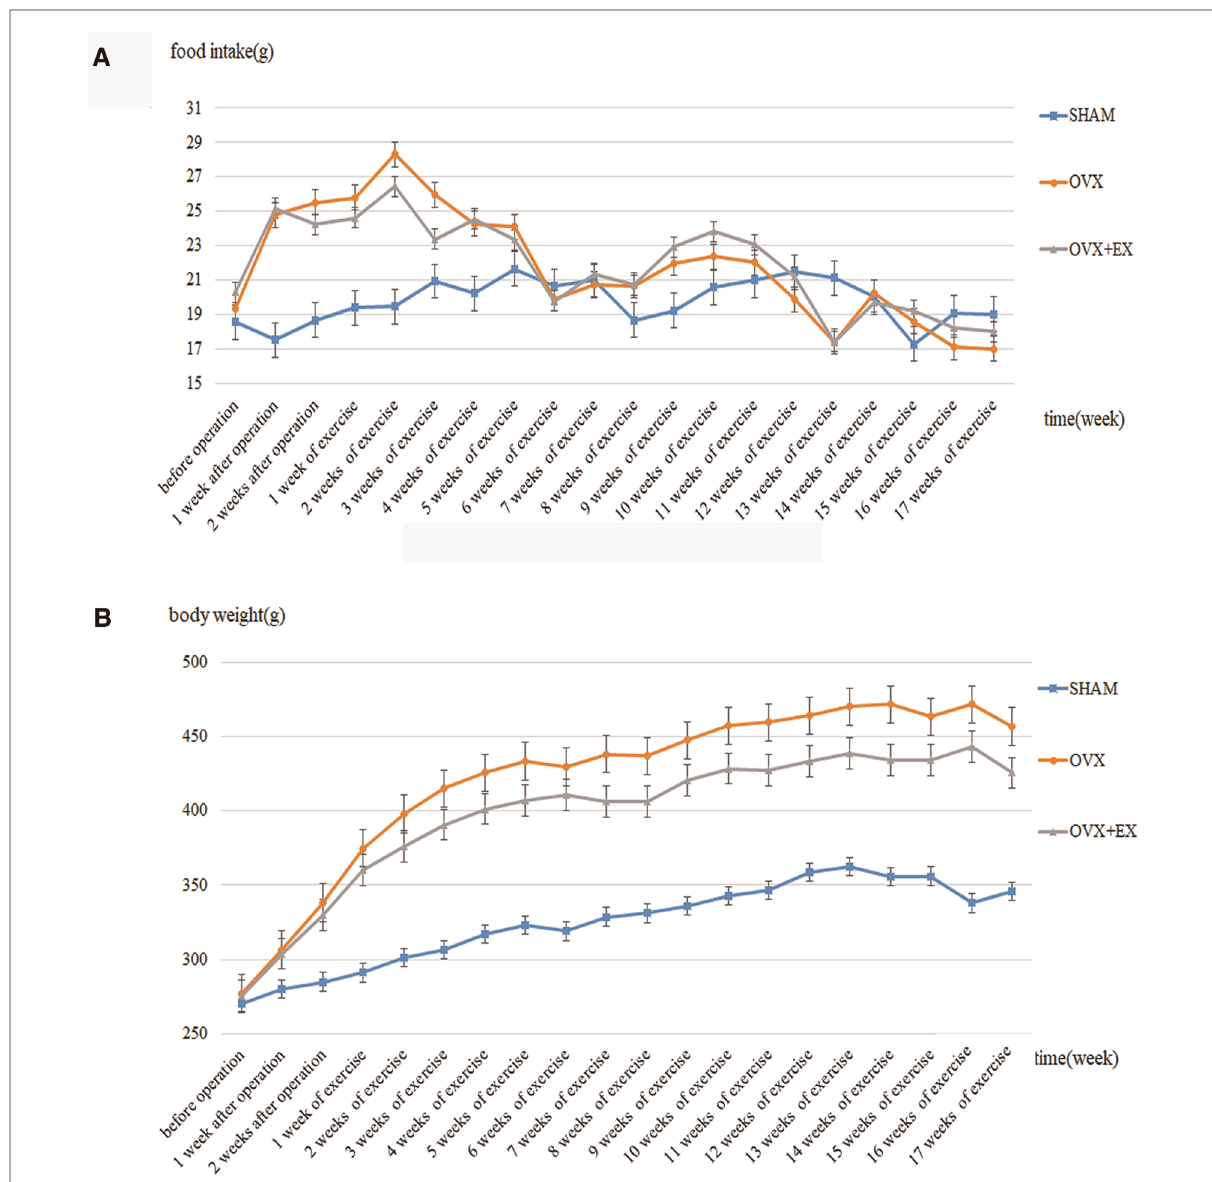
FIGURE 1 Dynamic change of the food intake and the body weight in rats. (A) Dynamic change of the food intake in rats; (B) Dynamic change of the body weight in rats.